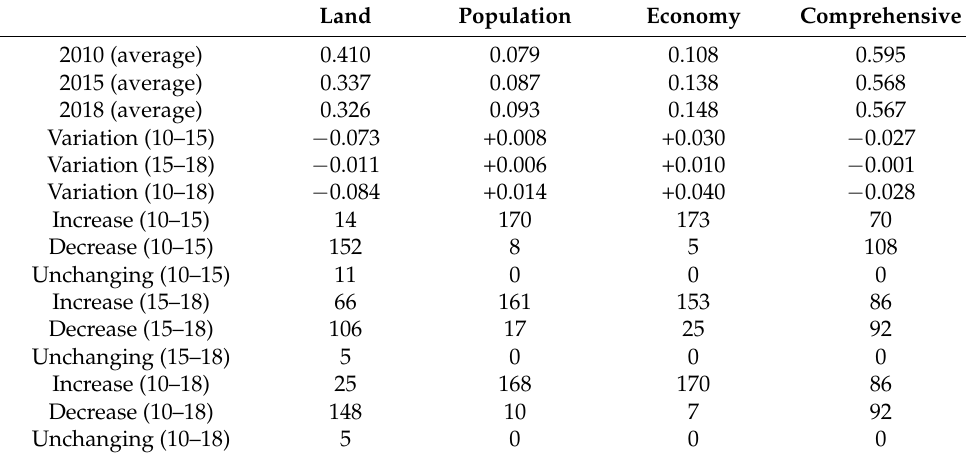
Table 4. Variation of rural hollowing in 2010, 2015 and